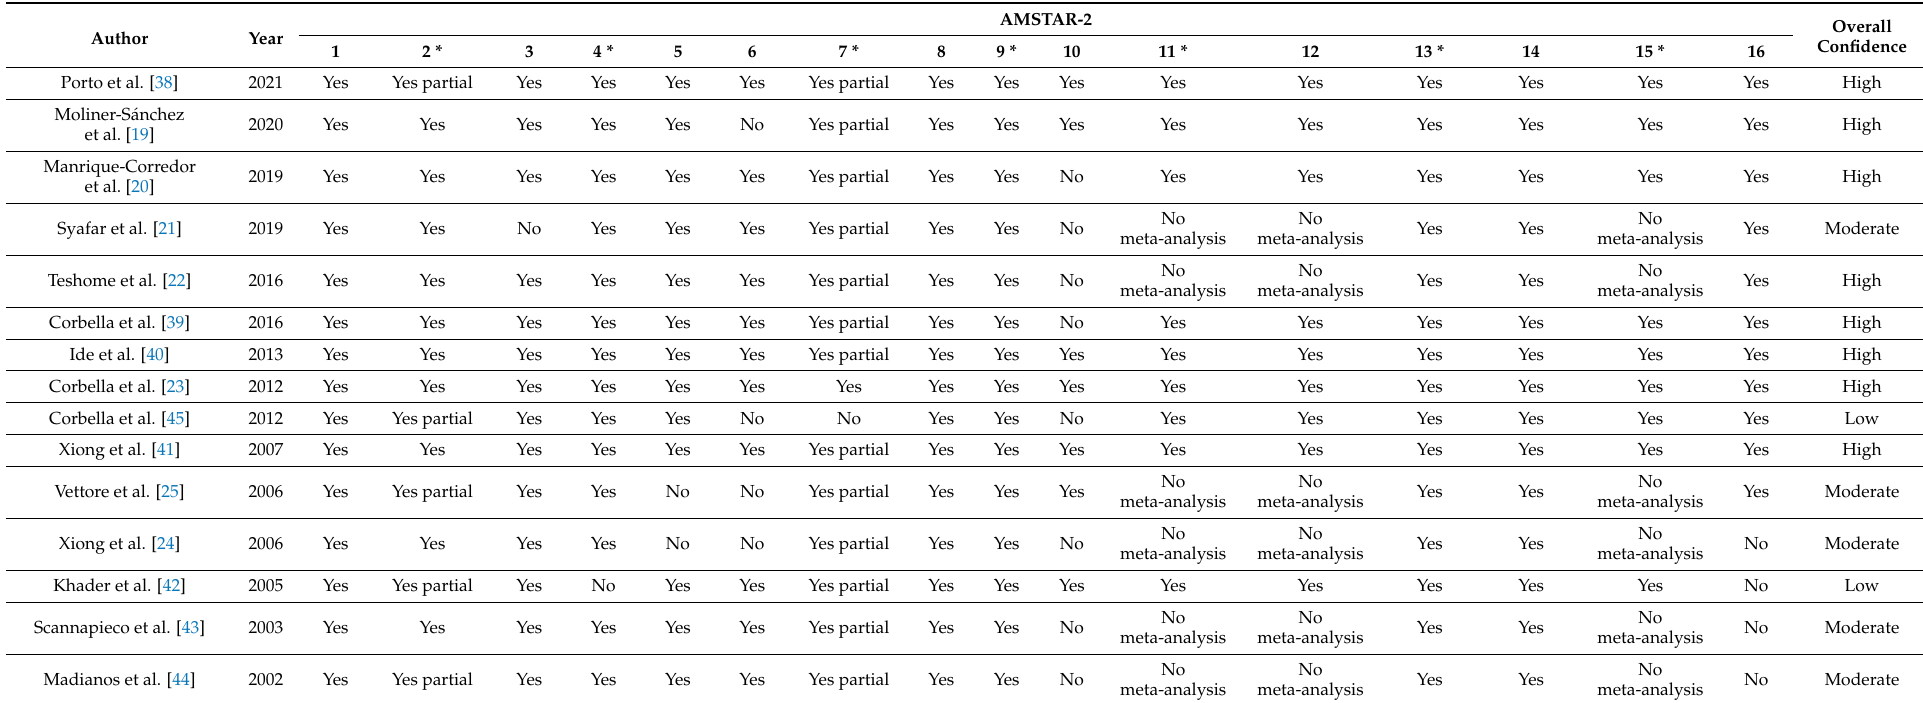
Table 4. Risk of bias in the analysis of the included